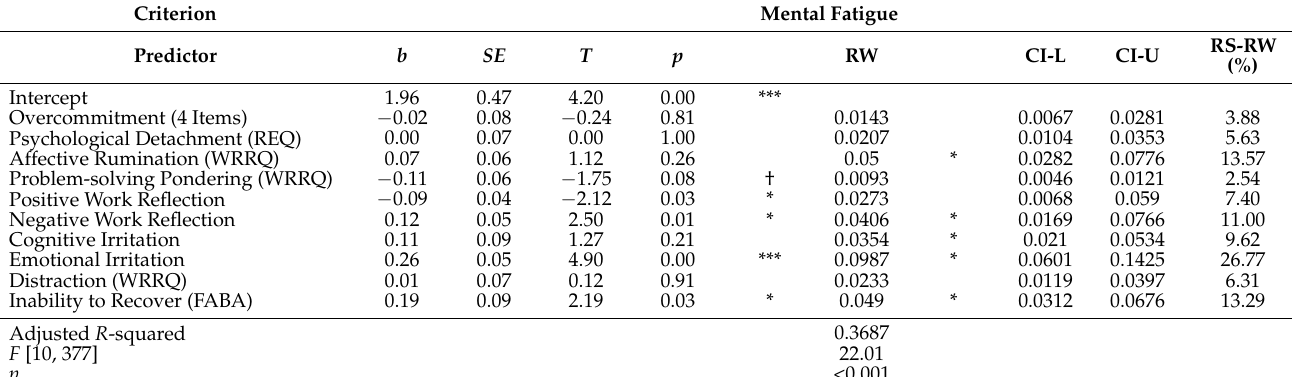
Table 9. Coefficients of the Relative Weight Analyses Predicting Mental Fatigue (Sample